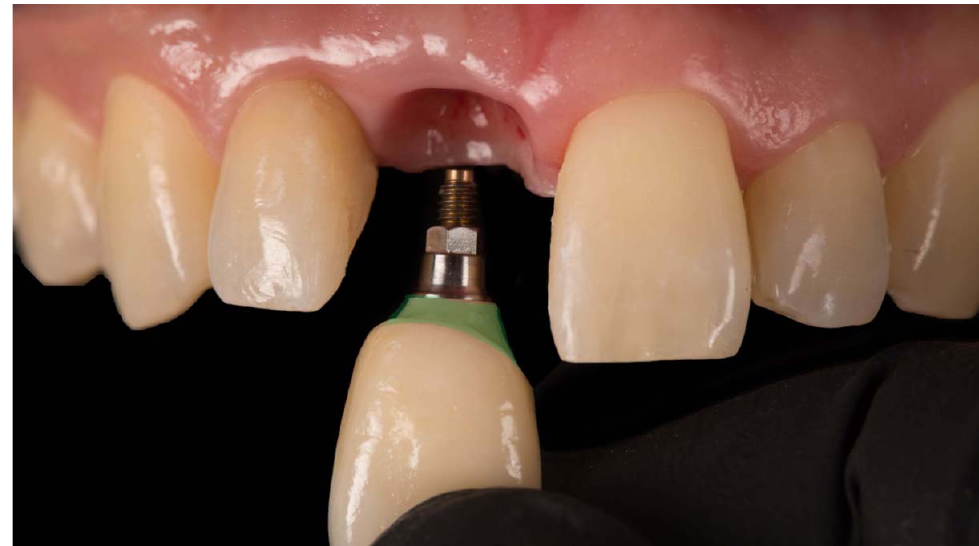
Figure 7. The restoration area marked in green will face peri-implant soft tissues from the junctional to the sulcular epithelium areas, respectively. Frontal view.